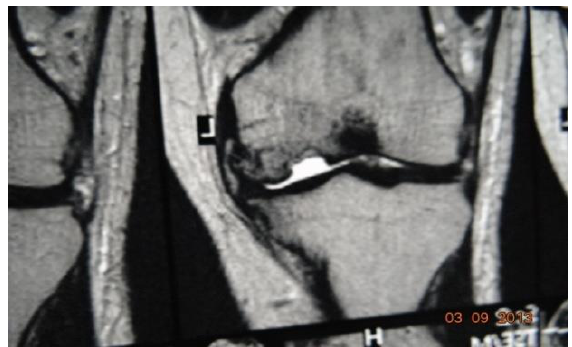
Fig2: MRI picture of femoral osteocondylar cartilaginous lesion